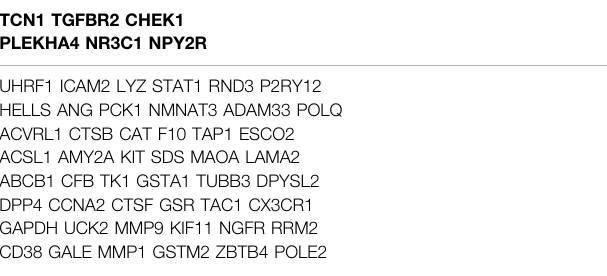
TABLE 1 | Overlapping targets of trastuzumab and breast cancer.